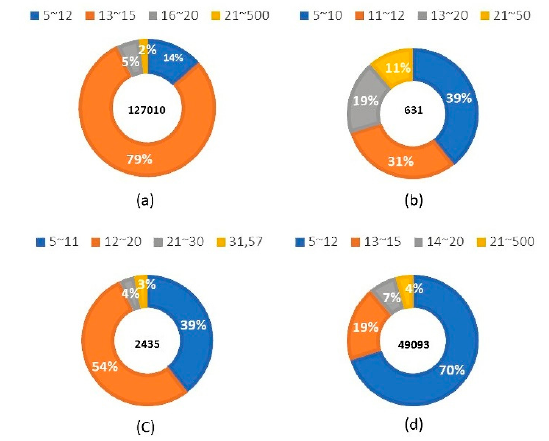
Figure 3. Frequencies of various epitope lengths from the following data sets: ( a ) non-BCE; ( b ) IgA epitope; ( c ) IgE epitope; and ( d ) IgG epitope.